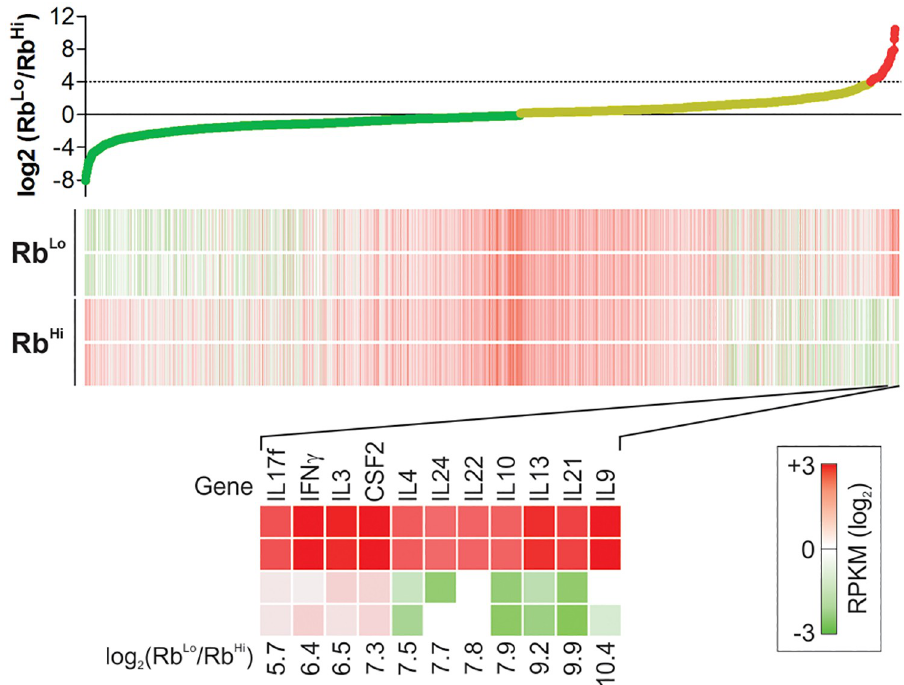
Fig 4. Rb Lo Tem and Rb Hi Tn transcriptomes reveal potential crosstalk mediators. Rb Lo Tem and Rb Hi Tn cells were stimulated alone as before for 3 days, and RNA was isolated for deep sequencing and whole transcriptome analysis. Genes were arranged according to the log2 of the Rb Lo Tem to Rb Hi Tn ratio of expression, using the calculated RPKM values. Candidates were narrowed by excluding all membrane proteins, proteins known to exist only in the nucleus or cytoplasm, and those showing at least 16-fold increase in Rb Lo Tem cells compared to Rb Hi Tn cells. n = 2 per cell type.